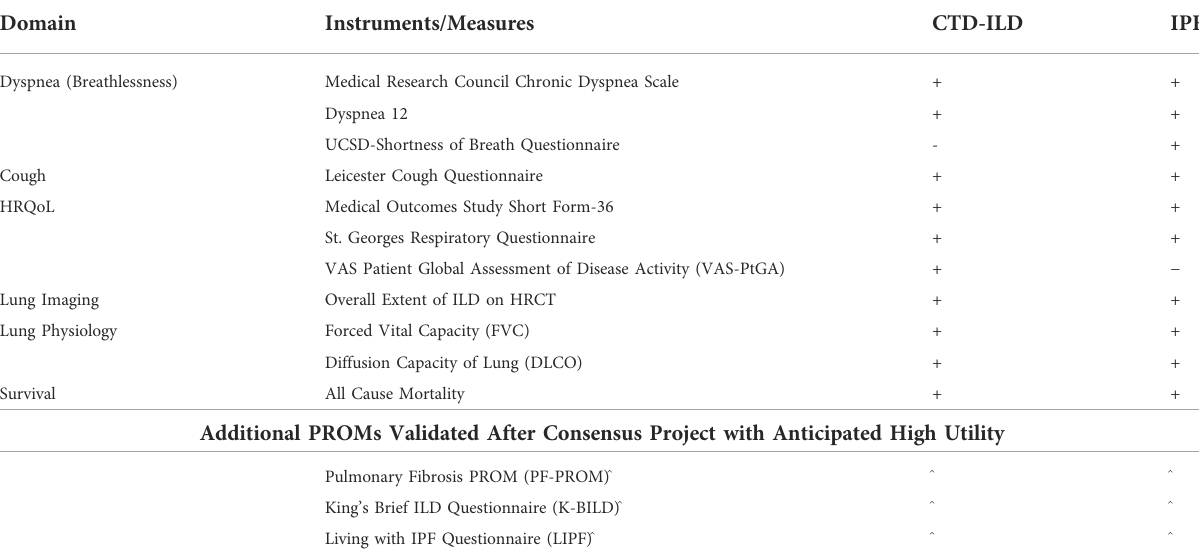
TABLE 1 Consensus on minimal core sets of instruments and measures for IPF and CTD-ILD trials (Saketkoo et al., 2014b) Domain